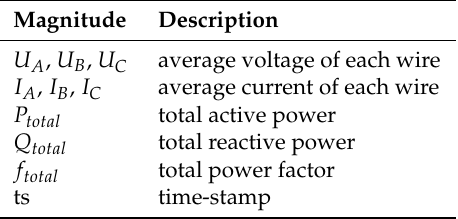
Table 1. Electrical magnitudes of three-phase